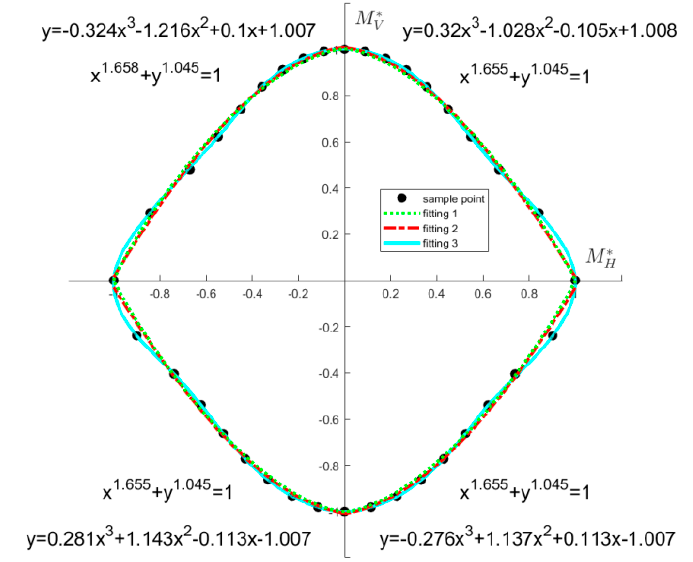
Figure 18. The case of an intact hull.